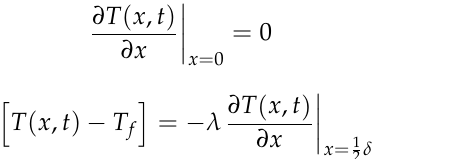
Table 2. Sample properties for treatment [25]. Parameter (Unit) Value Density (kg/m 3 ) 7 × 10 2 Transversal thermal conductivity (W/(m · K)) 17 × 10 − 2 Convective heat transfer coefficient (W/(m 2 · K)) [26] 158 × 10 −